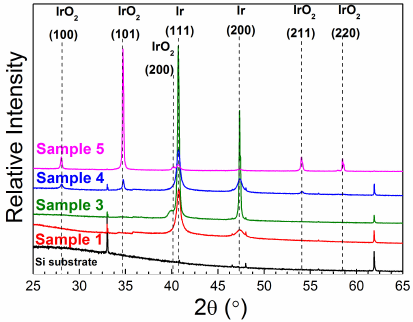
Figure 2. Diffraction patterns of iridium coatings on Si (100). An increase in the oxygen flow rate strongly promotes the formation of the oxidized iridium. For example, its four-fold increase is sufficient for the formation of crystalline IrO 2 even at a deposition temperature of 310 ◦ C (sample 4, Figure 2). With a two-fold increase, the oxide phase becomes dominant already at 330 ◦ C (sample 5, Figure 2). The strong preferred orientation of IrO 2 crystallites along the (101) direction is observed for this sample. The unit cell parameters of iridium oxide calculated here ( a = 4.497(2) Å, c = 3.155(3) Å) correspond to pure tetragonal IrO 2 ( a = 4.505 Å, c = 3.159 Å, PDF 010- 88-0288 [29]). According to CSR, the average size of these (101)-oriented crystallites is 130(13) nm and the (110)-oriented crystallites is 85(9) nm. The appearance of a crystalline oxide phase in the coatings causes corresponding changes in their microstructure. Specifically, three types of particles appear on the surface of the mixed samples: (1) square nanotubes, (2) incomplete/scrolled nanotubes, (3) wedge- shaped rods. The types (1) and (2) are observed in sample 4 with the diameters about 30–50 nm and up to 100 nm, respectively (Figure 1c). The surface of sample 5 is mainly formed by particles (2) with increased sizes (up to 400 nm); particles (3) are also present (Figure 1d). In general, the observed changes in the particle shapes depending on the deposition conditions are consistent with the findings described in the study of the mor- phology evolution of IrO 2 crystals in MOCVD processes using [Ir(cod)(Cp Me )]